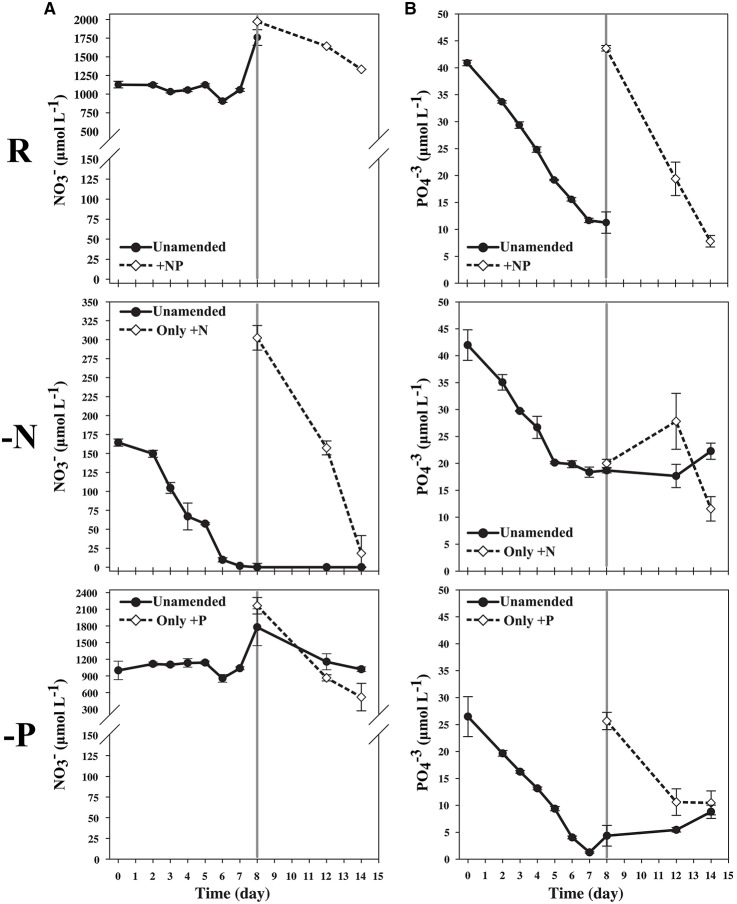
(A) Nitrate measurement illustrating low starting N concentration in the N-limited culture and depletion over time until day 7. Cultures, starved for 24 hours, were sampled on the 8th day. The remaining 300 mL were split into 150 mL cultures, and additional nitrate was added to one of the flasks originating from the N-limited treatment. (B) Phosphate measurements illustrating lower starting concentration of P in the P-limited culture, and depletion of P over time until day 7. The culture was starved 24 h, and sampled on the 8th day. The remaining culture was split into two equal volumes and phosphate was to one of the flasks originating from the P-limited treatment.